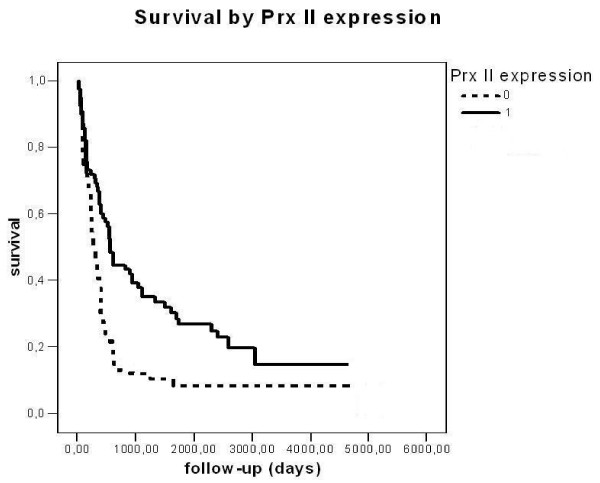
Survival by peroxiredoxin II in primary astrocytic brain tumors. Tumors were divided in two groups, Prx+ and Prx-. The difference between the groups is significant (p = 0.0002, log-rank test).